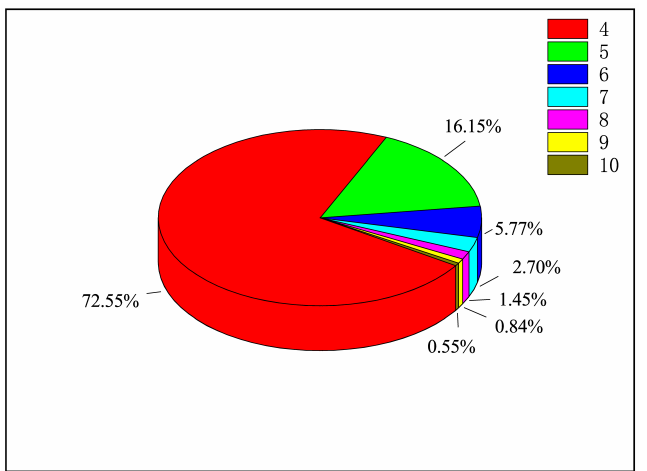
Figure 10. The proportions of nl ( n = 4 − 10) energy levels to the total cross-section in EA processes of the ground state W 38 +